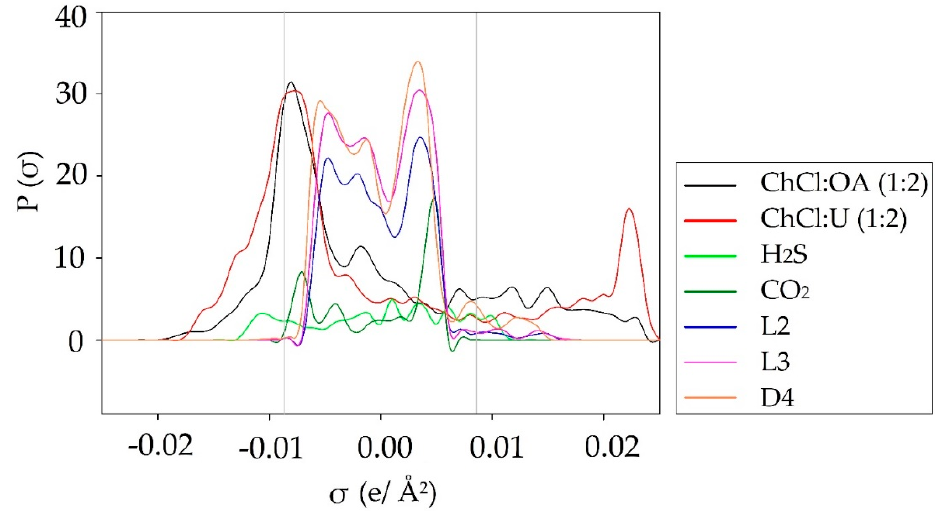
Figure 5. σ -profiles of ChCl:OA (1:2), ChCl:U (1:2), H 2 S, CO 2 , and siloxanes (L2, L3,